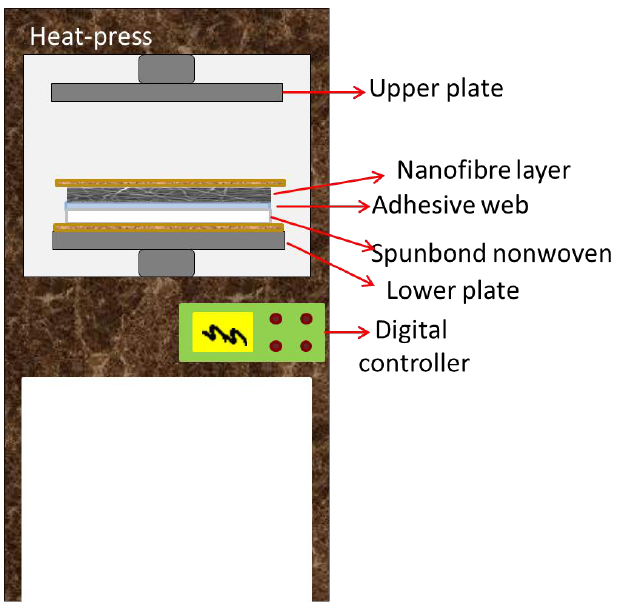
Figure 2. Schematic design of the heat-press equipment and replacement of the multilayer nanofibrous